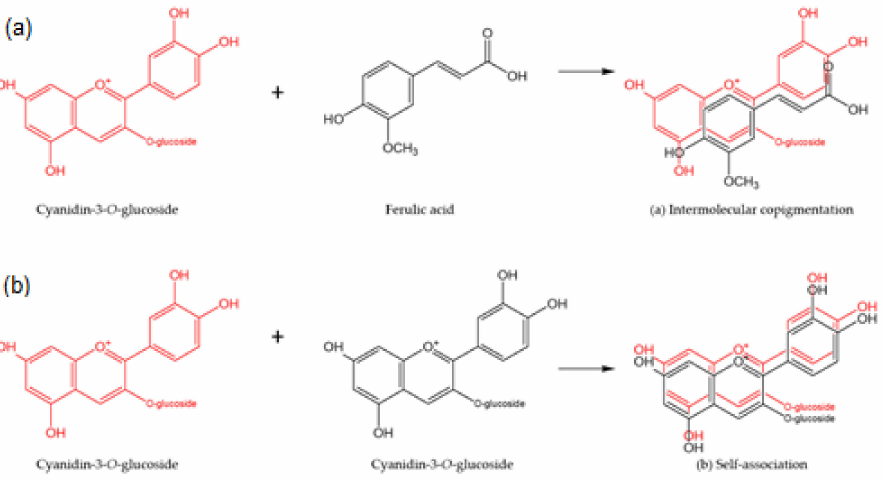
Figure 2. Examples of anthocyanin interaction. ( a ) Intermolecular copigmentation and ( b ) self- association. Adapted from Castañeda-Ovando et al.